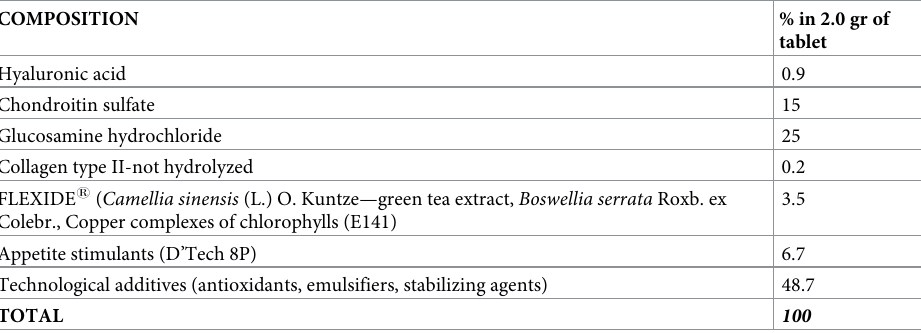
Table 2. Composition of the feed supplement used during the study.